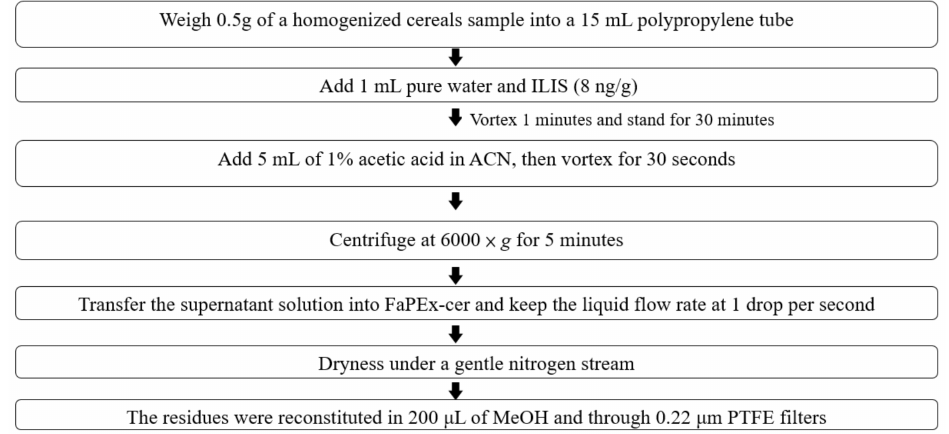
Figure 1. The flowchart of sample preparation: